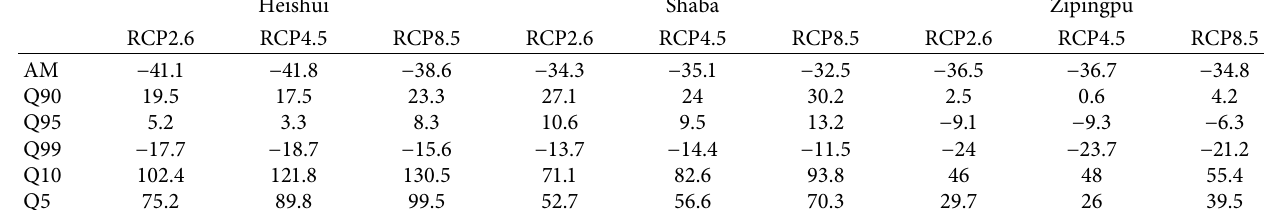
Table 10: Variation of extreme runof in the upper reaches of the Minjiang River from 2021 to 2050 (%). Heishui Shaba Zipingpu RCP2.6